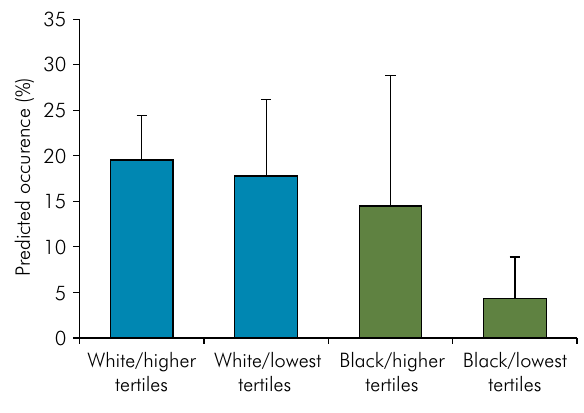
Figure 3. Predicted occurrence of amalgam replacement (% (CI 95%)) for composite resin by individuals’ skin color and familiar income. Results adjusted by final